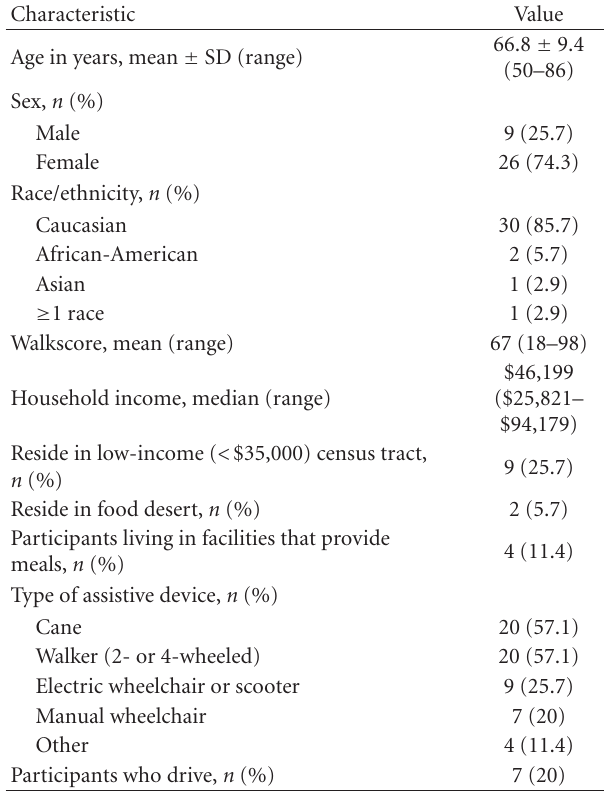
Table 1: Characteristics of study participants ( n =